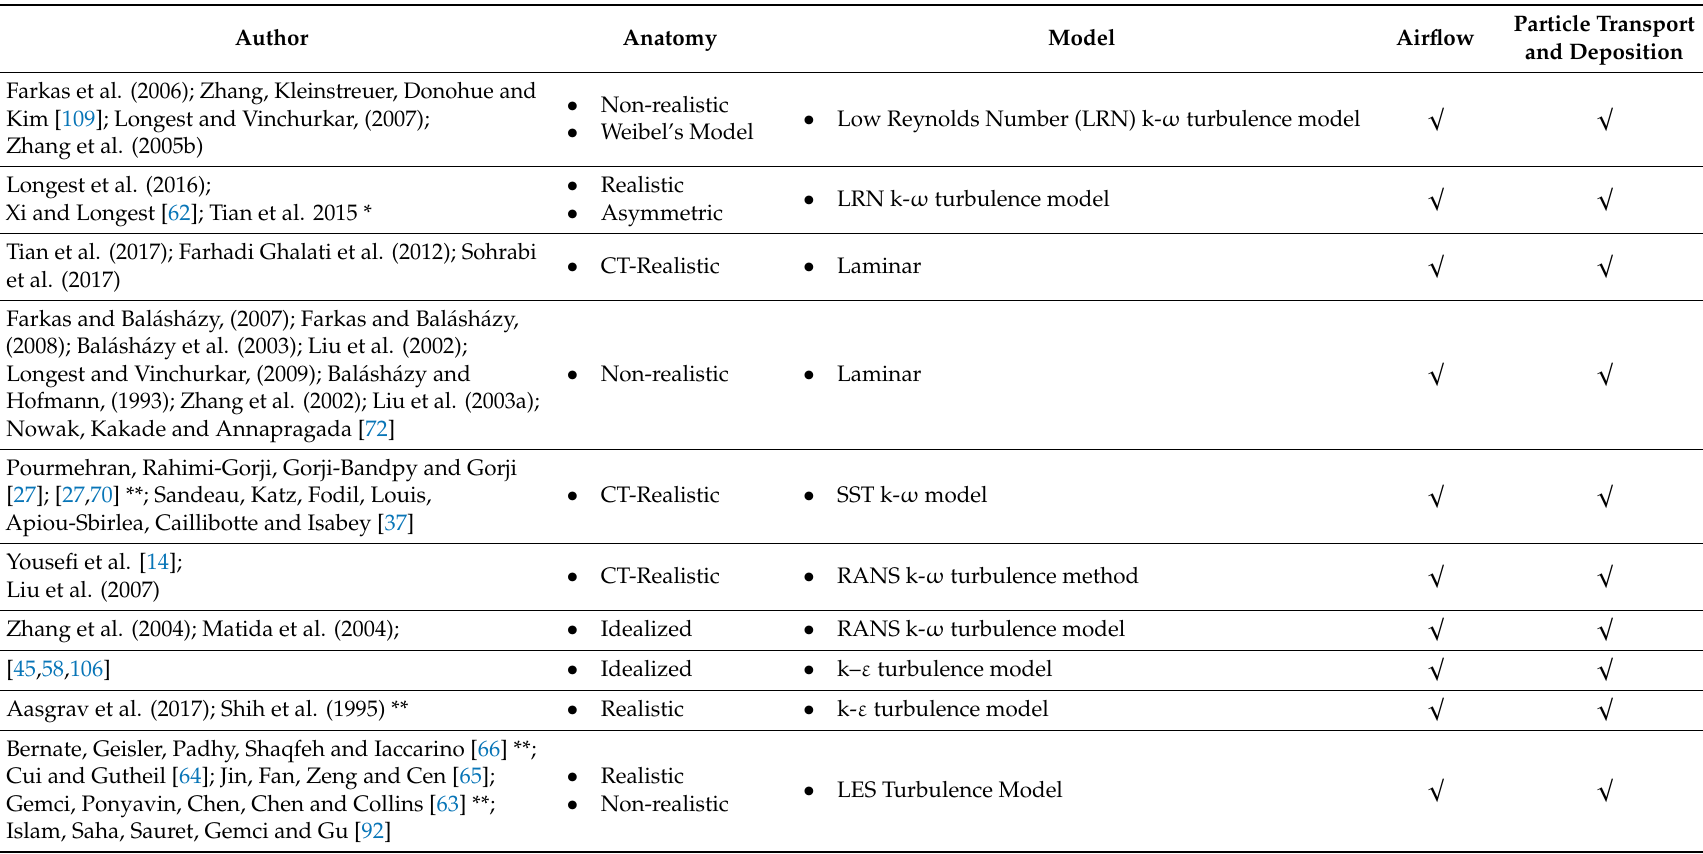
Table 4. Literature on di ff erent turbulence modelling for airflow and particle